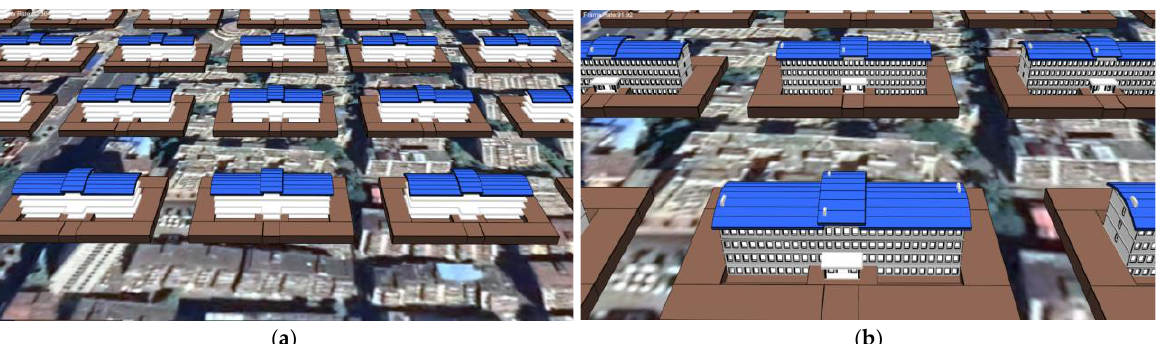
Figure 9. BIM models and oblique aerial images for the red area: ( a ) LOD2 (level-of-detail) models; ( b ) LOD3 models.